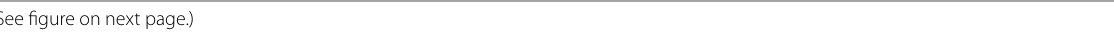
figure on next Fig. 5 a Examples of the three fitting functions. This graph shows the fitting results using the three functions for event 11; the logistic function (top), error function (middle) and decaying exponential function (bottom). The solid line indicates the fitting curve overlapping on the observed data (one-dot chain line) for each function. The differences between the observed data and the fitting curve are plotted for each function. b Fitting results of the decaying exponential function for the 11 events. This graph shows the fitting curves of the decaying exponential function (solid line) and the observed data (the one-dot chain line) for the 11 earthquakes from event 2 to event 12. The differences between the observed data and the fitting curves are plotted for each event. The amplitude of the groundwater level and fitting data are plotted at same scale for the all